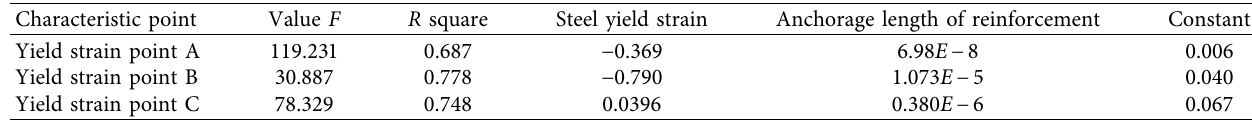
Table 5: The strain fitting results of the characteristic